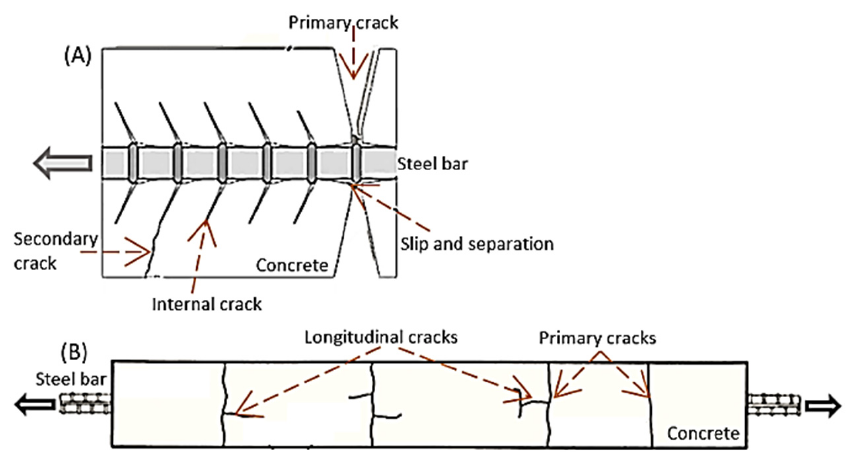
Figure 5. Detailed representation of ( A ) concrete cracking (primary, secondary, internal concrete cracking) and ( B ) primary then longitudinal cracking due to tensile stresses (Reproduced with permission from reference [38]).